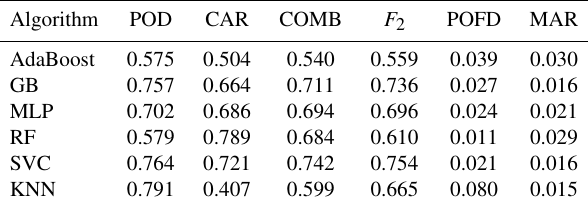
Table 2. Averaged performance metrics of the cross-validation for all tested algorithms over the nine year training period